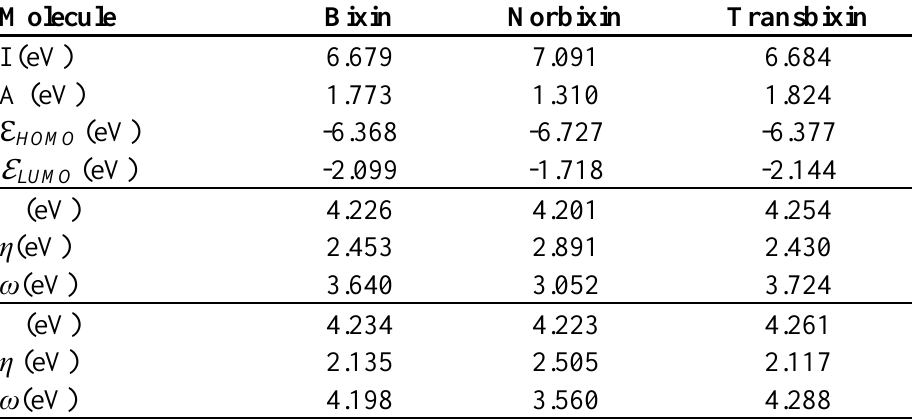
Table 7. Ionization potential I, Electron affinity A, HOMO energy, LUMO energy, electronegativity, global hardness and global electrophilicity of bixin, norbixin and transbixin calculated with the M05-2X/6-31+G(d,p) level of theory and Eqns. 3, 4 and